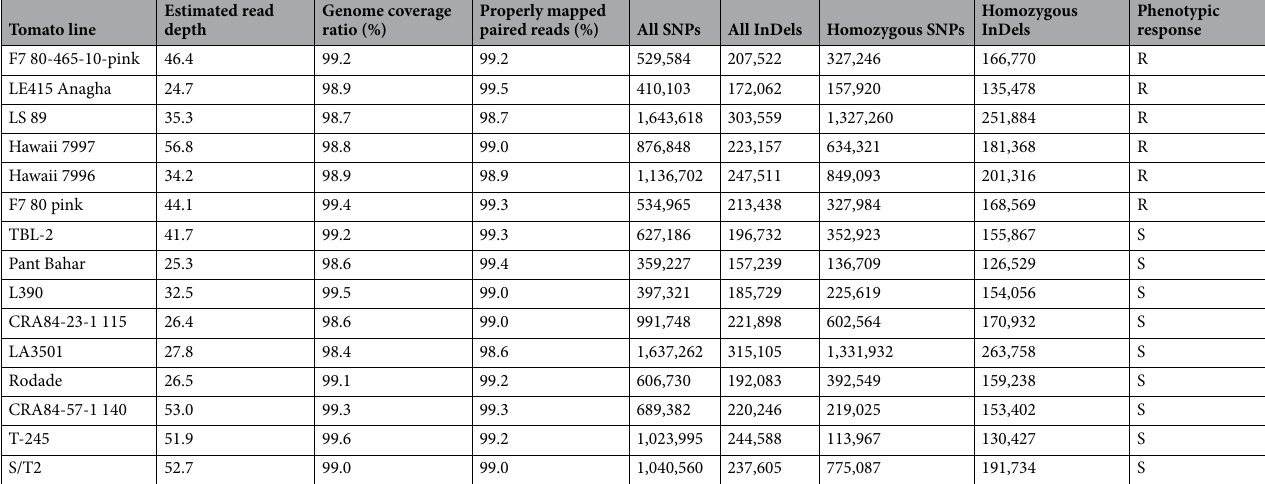
Table 2. Summary statistics of the sequence quality, coverage and polymorphisms of the bacterial wilt (Pss4 (race 1, biovar 3, Ralstonia pseudosolanacearum ) and Pss1632 (race 3, biovar 2, R . solanacearum ) resistant and susceptible tomato